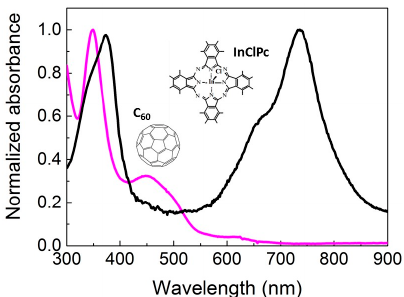
Figure 2. Normalized absorbance of C 60 and InClPc thin film. The insets are the molecular structures of C 60 and InClPc.